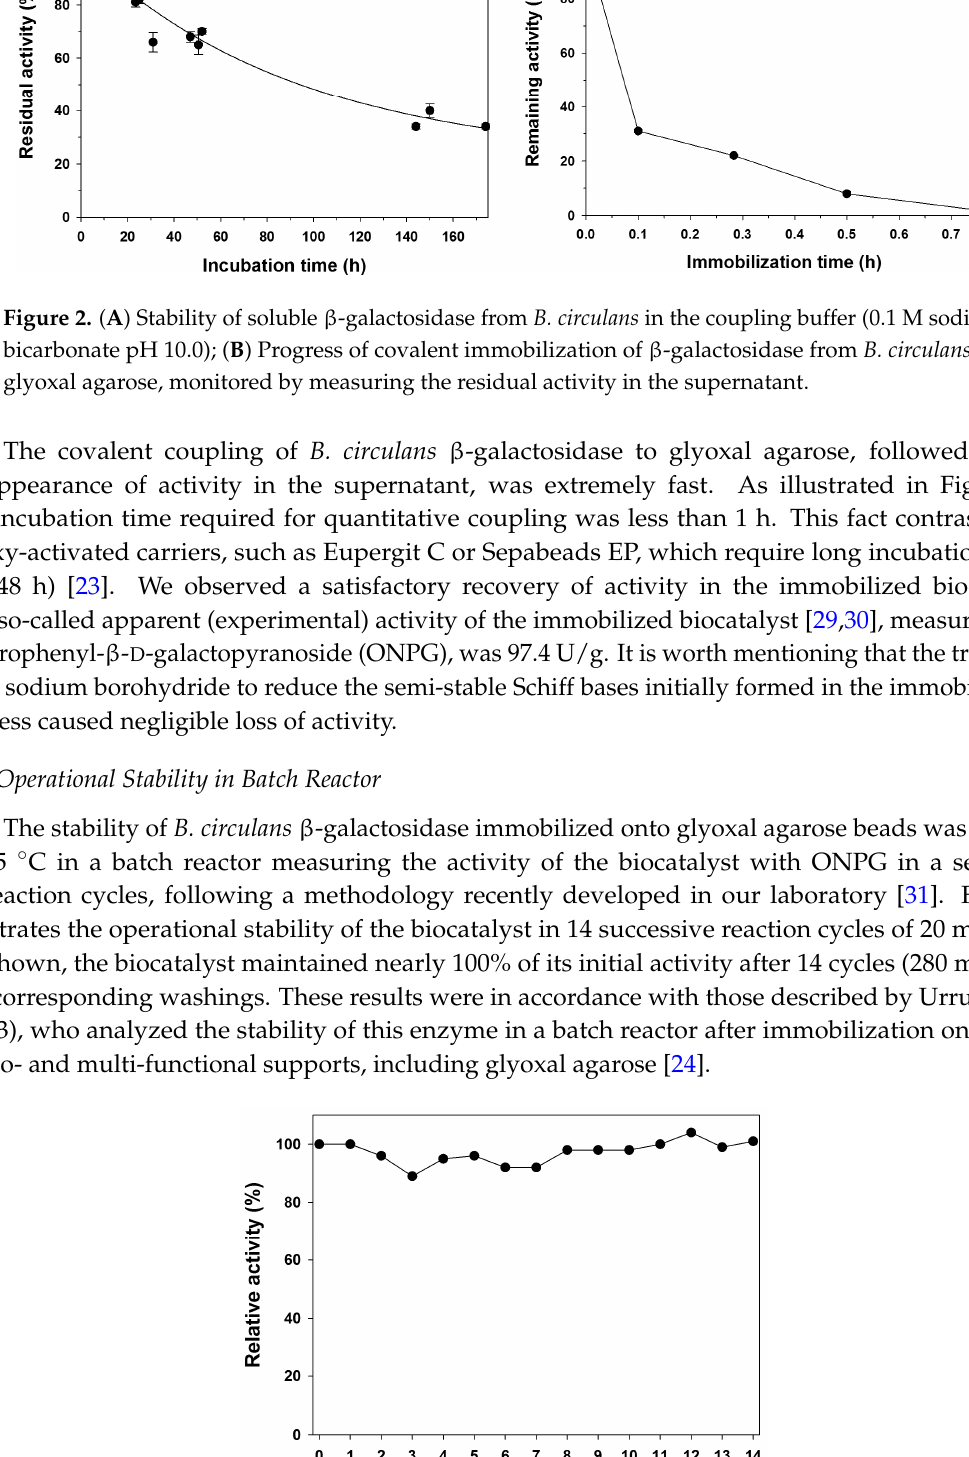
Figure 3. Reuse assay in a batch reactor of β‐ galactosidase from B. circulans immobilized onto glyoxal agarose beads. After each reaction cycle (20 min), the biocatalyst was filtered and washed with buffer. Reaction conditions: 15 mM ONPG in 0.1 M sodium acetate buffer (pH 5.5), 45 °C.